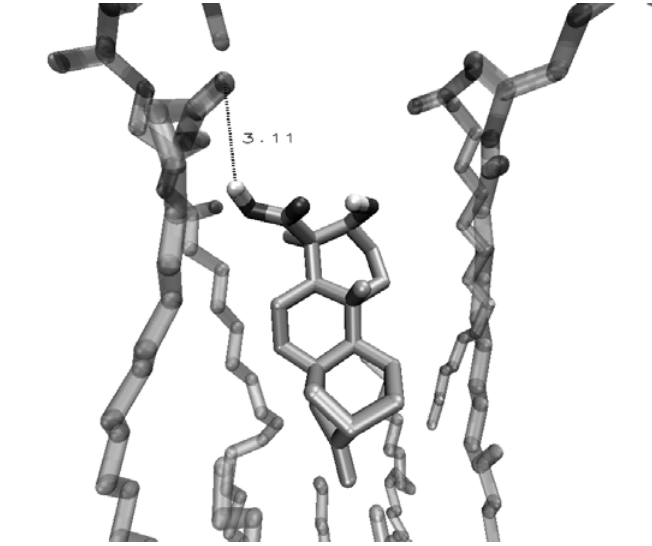
Figure 4. Mode of insertion of one molecule of ent –3- β -hydroxykaurenoic acid ( 3 ) into a POPC bilayer. The –CO H----O=P hydrogen-bond is now larger (3.11 Å) than the one 2 depicted in Figure 1 (1.91